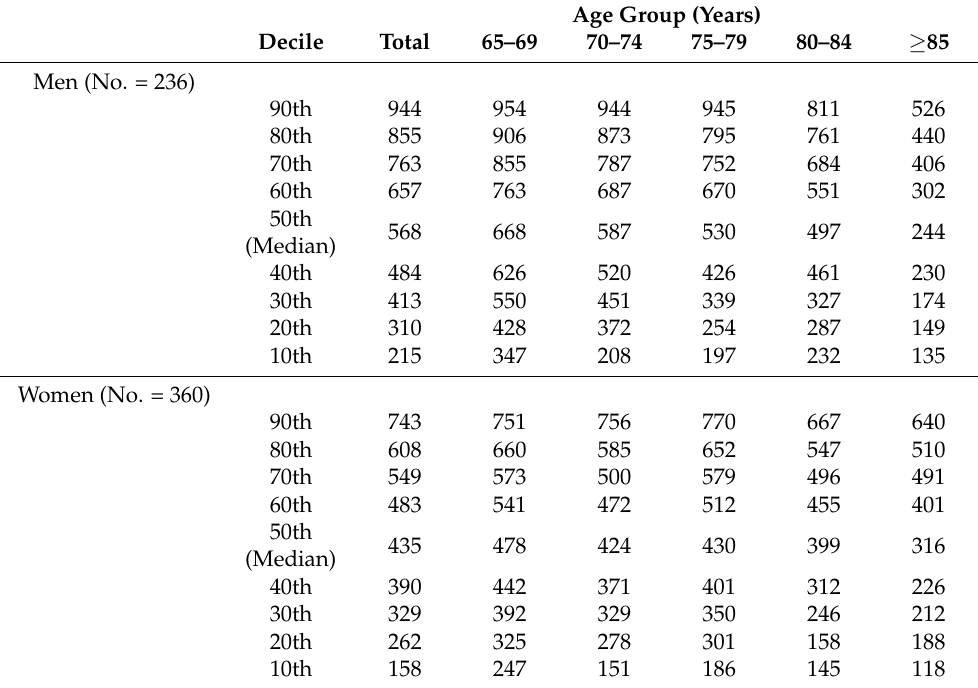
Table 3. Deciles of occlusal force by age group and sex.